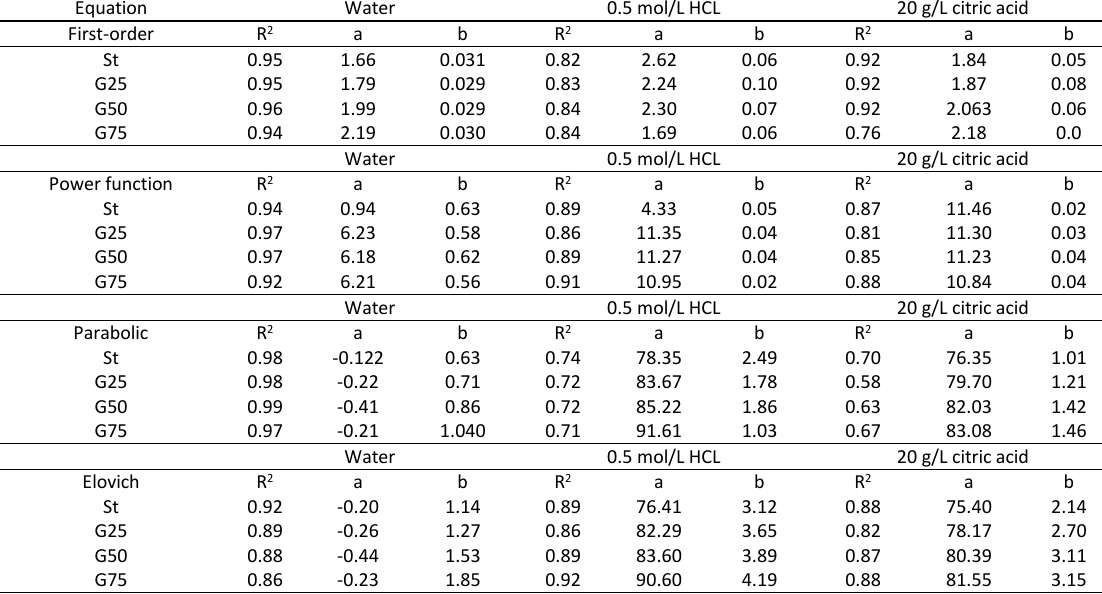
Table 8: Parameters of kinetic models for P release from the samples in water, HCL and citric acid